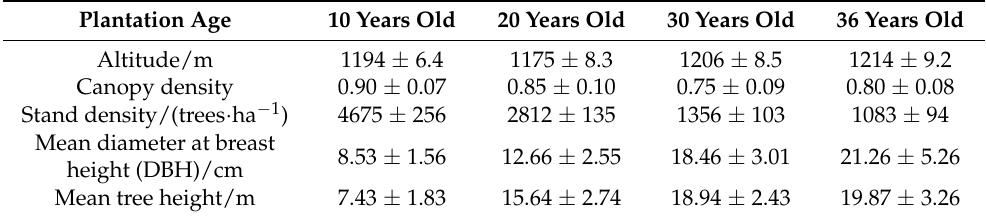
Table 1. Characteristics of Pinus massoniana plantations along a chronosequence. Plantation